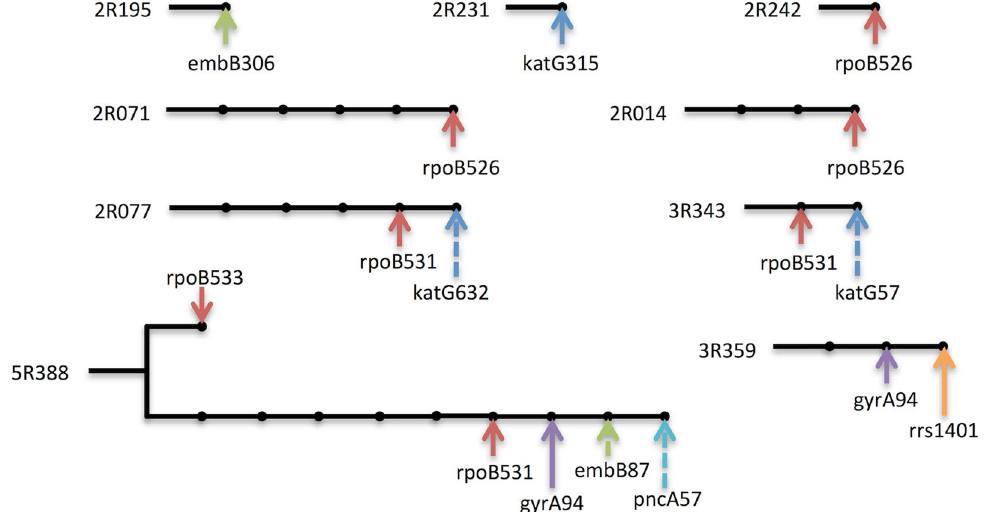
Figure 3. Accumulation of acquired resistance mutations as shown by whole genome sequencing. Lines or branches following the patient ID showed the distances of paired isolated. Each dot represented one SNP and arrows with different colors indicated mutations in different resistance genes. Solid arrows were detected and dash arrows were missed mutations by molecular